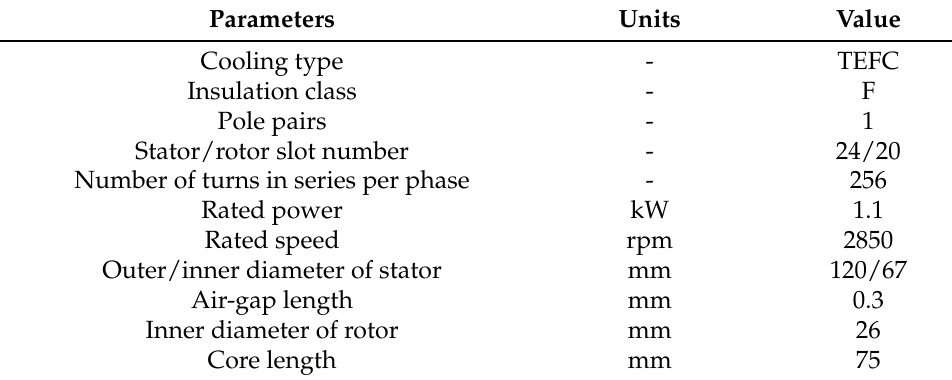
Table 1. Prototype parameters.